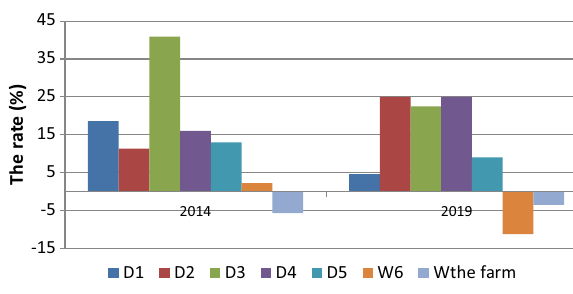
Fig. 8 The rate of change in Ca +2 between 2014 and Table 6 Calcium (mg/l) values of water points in the Mougheul area (2009–2019)